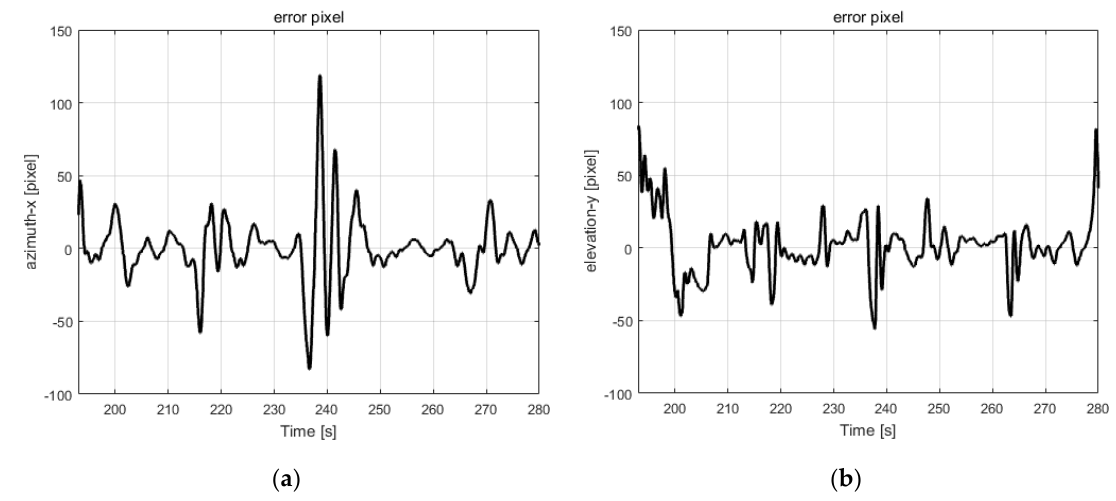
Figure 18. Boresight error in pixels while the UAV is tracking a flying drone. ( a ) the response in azimuth; ( b ) the response in elevation.